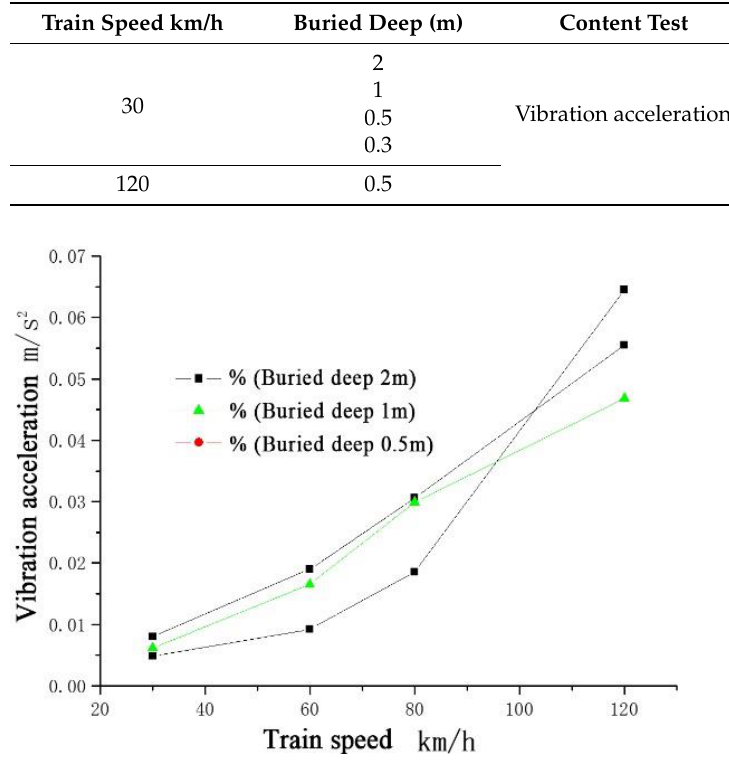
Figure 8. Vibration acceleration – train speed changing curves.